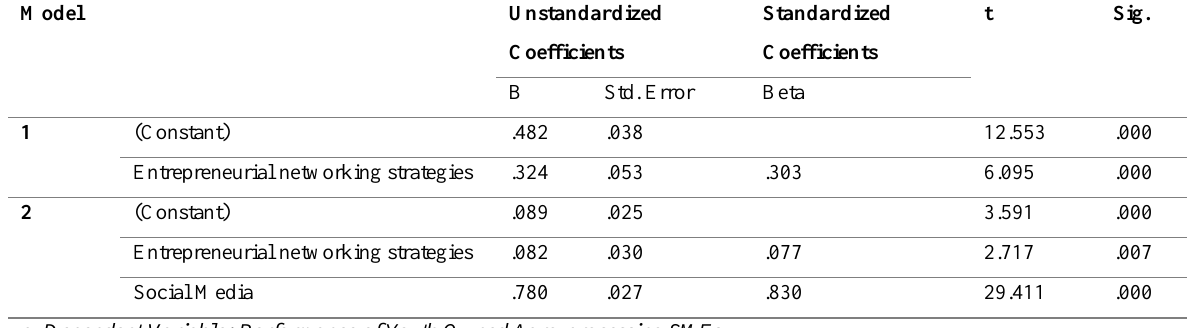
Table 7: Coefficients for Moderating Effect of Social Media on Relationship between Entrepreneurial Networking and Performance of Youth Owned Agro-Processing